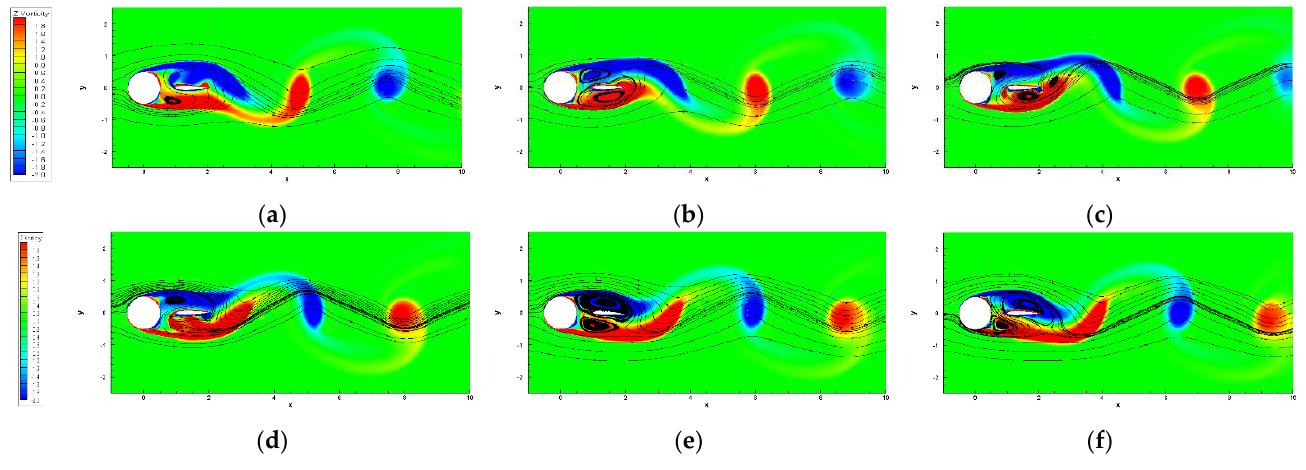
Figure 11. The flow mechanism ( x / D = 1.0, T / T 0 = 0.5): ( a ) t 0 ; ( b ) t 1 ; ( c ) t 2 ; ( d ) t 3 ; ( e ) t 4 ; ( f ) t 5 .